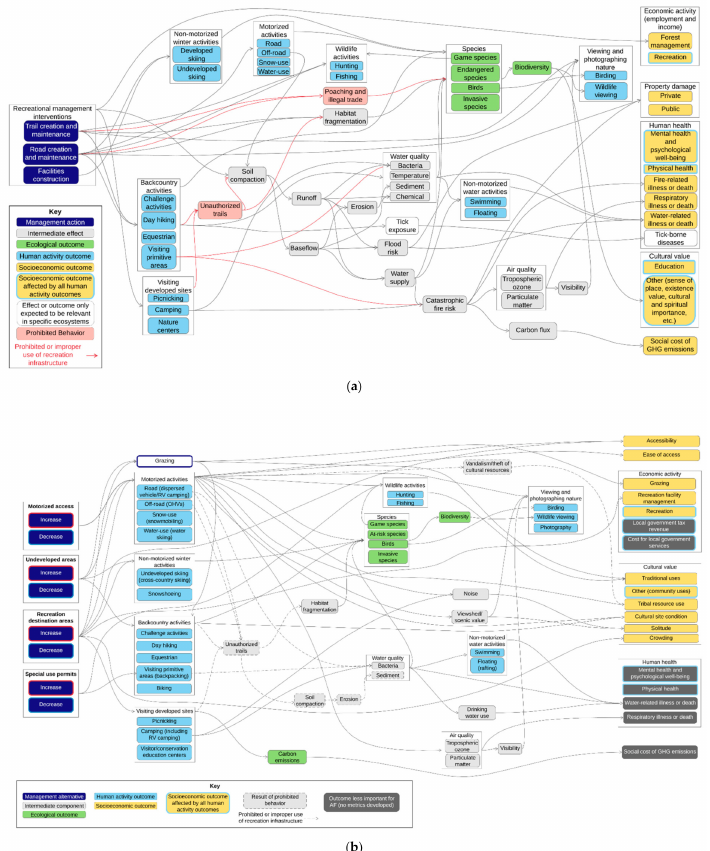
Figure 2. This figure shows the ( a ) original recreational management ESCM built for project scale planning and management; and ( b ) the adapted recreational management ESCM built for the Ashley planning process. In both models, socio-economic outcomes (yellow boxes) with blue outlines indicate that every human activity outcome (blue) would have an arrow going to that outcome. This was done to reduce the number of